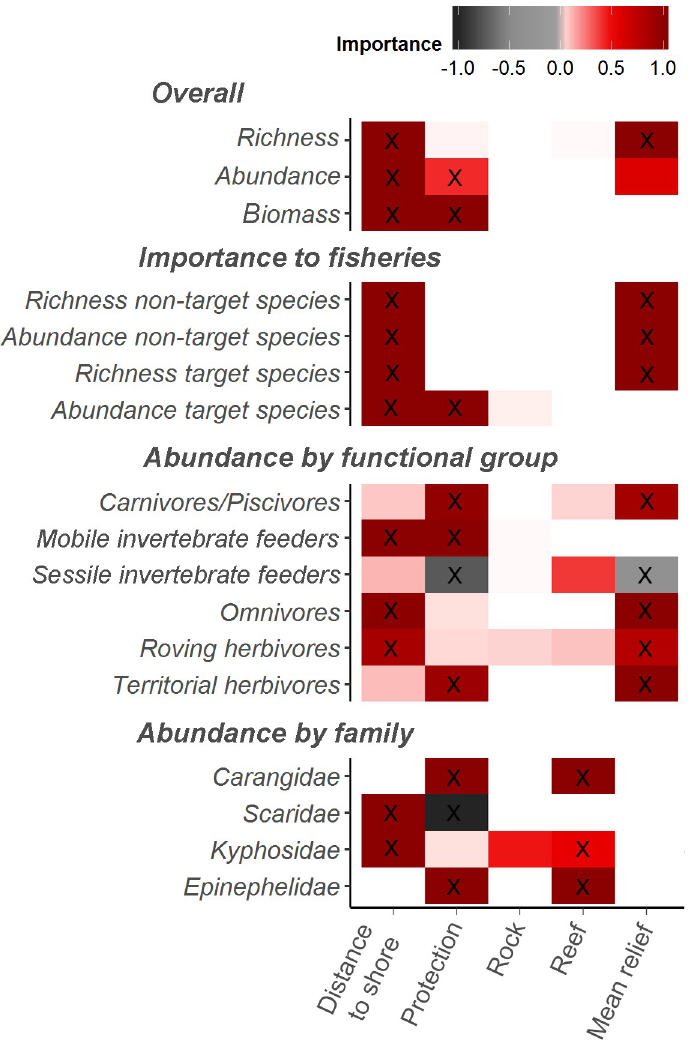
Fig 2. Variable importance scores from full-subset generalised additive mixed models analysis, with > 10% variance explained shown. X = Predictor variables within the most parsimonious model for each response variable (see Table